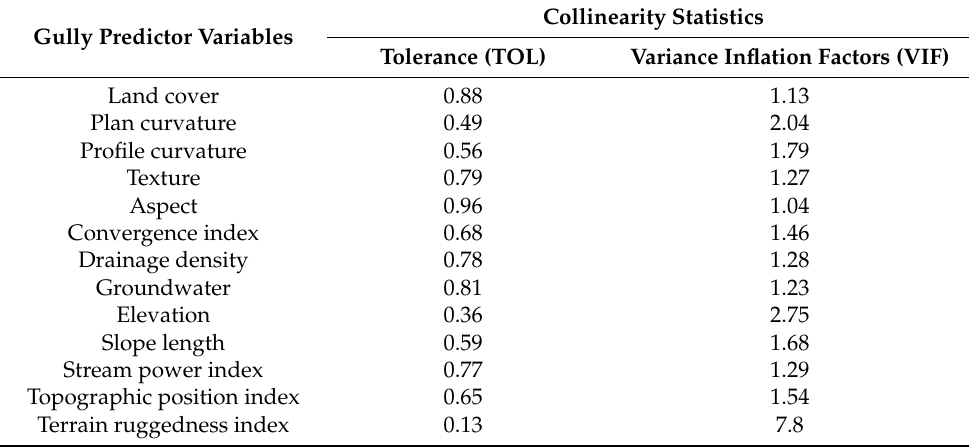
Table 3. Multicollinearity test statistics of gully predictor